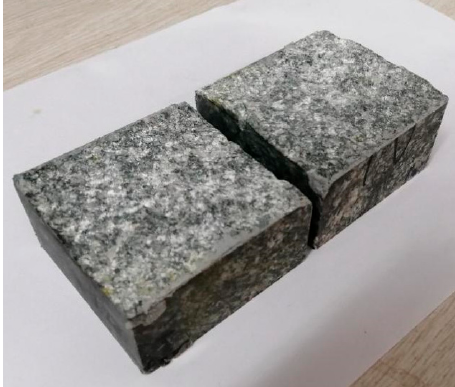
Figure 3. Rock fractures prepared by Brazilian splitting test.